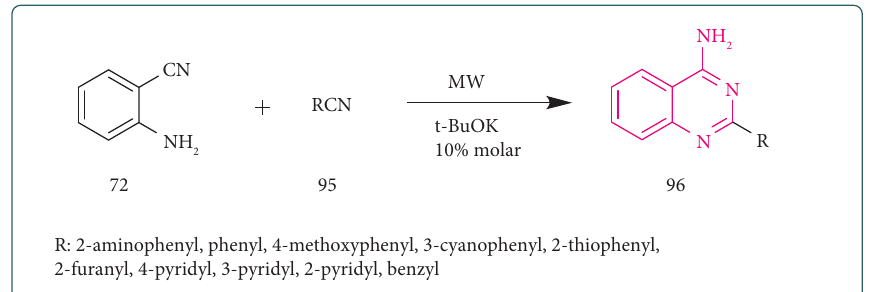
Scheme 16: Synthesis of 4-aminoquinazoline derivatives using 2-aminobenzonitrile under microwave